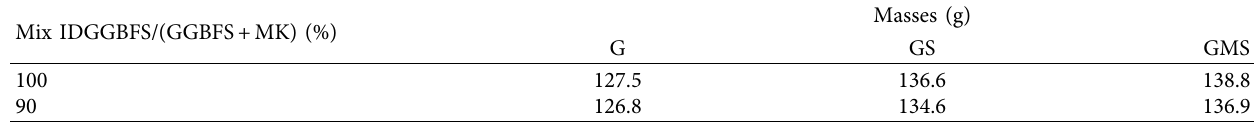
Table 5: Various GGBFS amount with various water